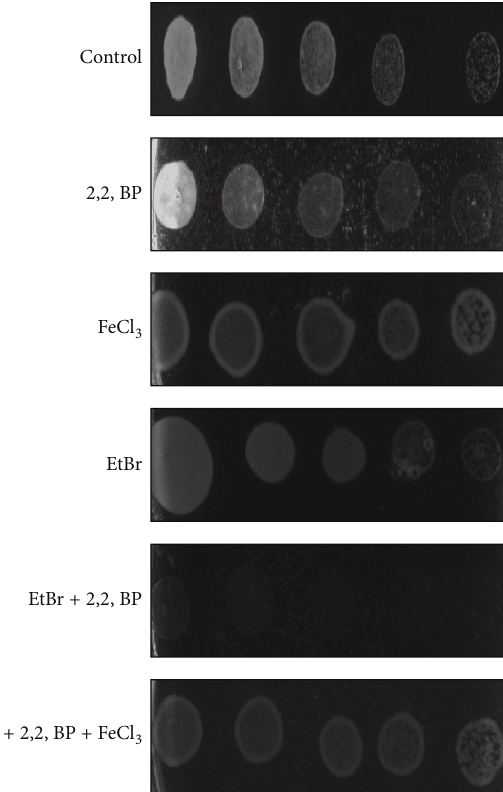
Figure 7: Indispensability of iron to sustain genotoxic stress. Spot assay of M. smegmatis in the absence (control) and the presence of 2,2, BP (35 𝜇 g/mL) and DNA damaging agent (EtBr) at 13 𝜇 g/mL.